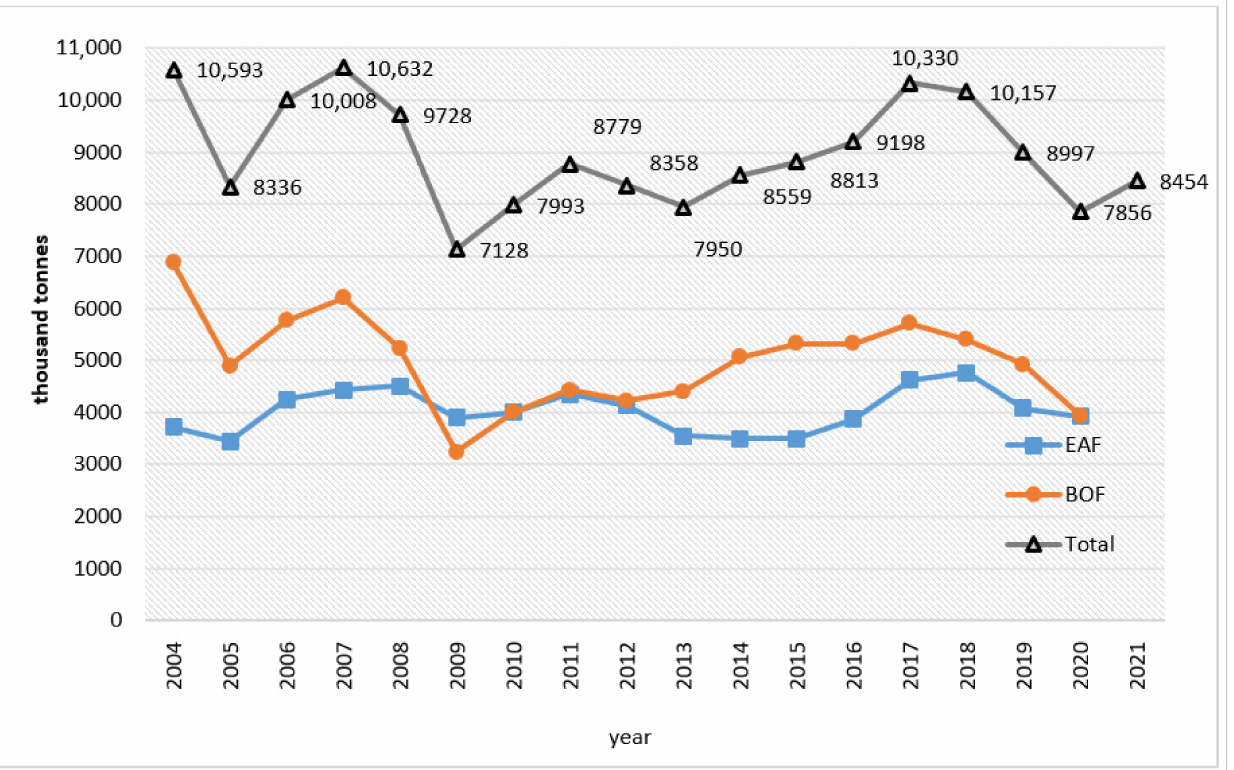
Figure 6. Steel production in Polish steel industry from 2004 to 2021. Total = EAF + BOF. Source: